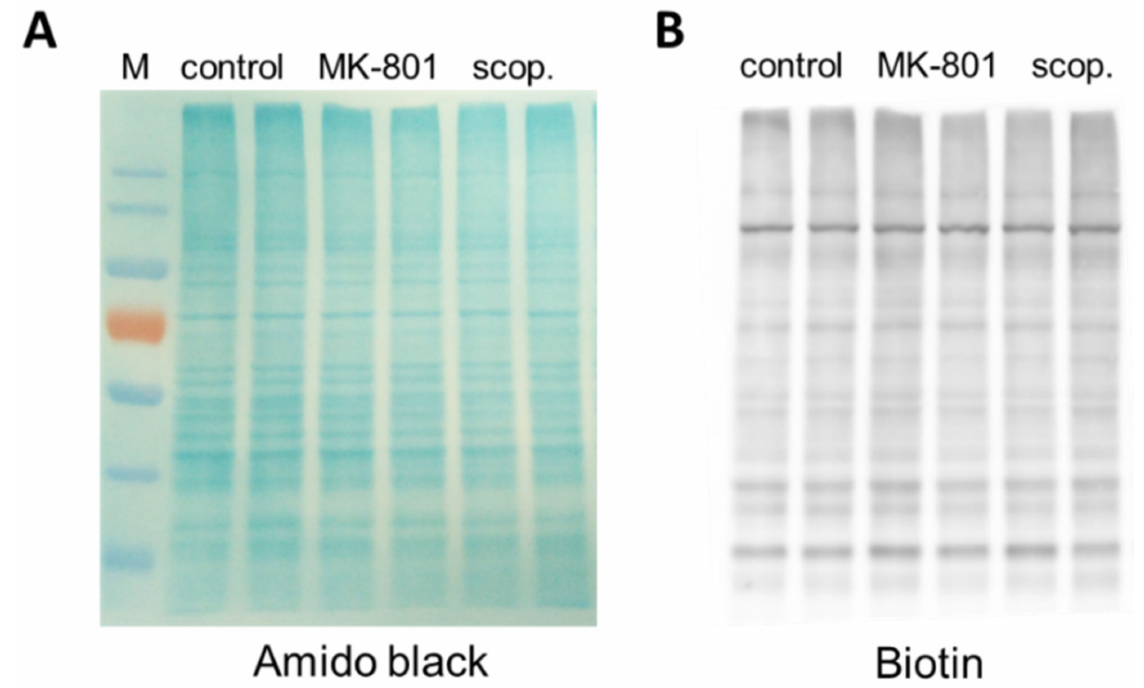
Figure 19. Representative results demonstrating the effects of chronic (14 days) administration of MK-801 or scopolamine on protein S-nitrosylation of the prefrontal cortex samples. ( A ) Proteins visualized by Amido Black staining on nitrocel- lulose membrane, ( B ) Western blot of total nitrosylated proteins labeled in biotin switch assay on the same membrane. M—protein